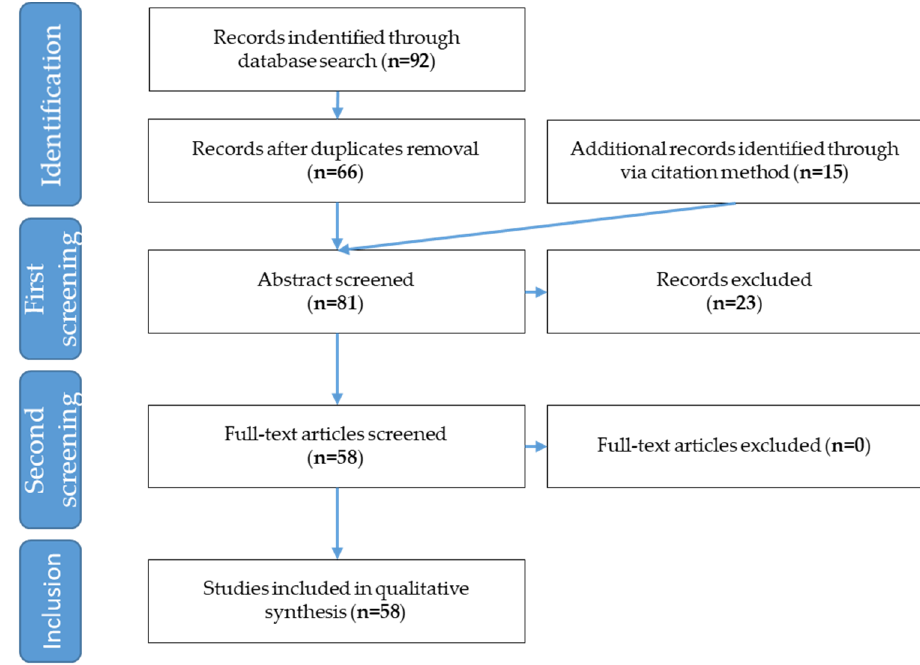
Figure 1. Flow chart of the systematic literature review process displaying exclusion and inclusion